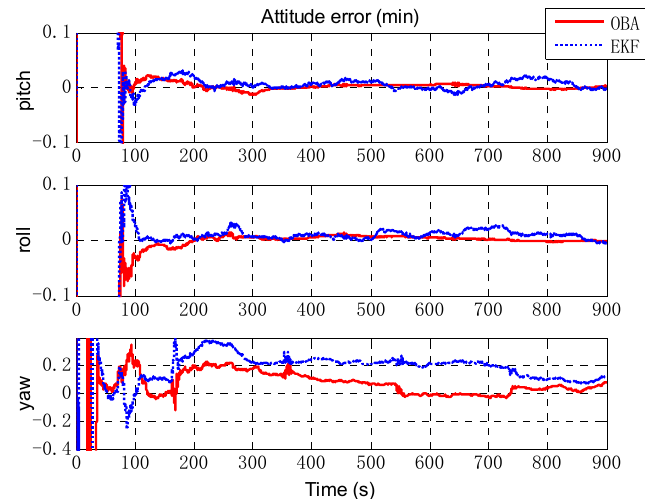
Figure 6. The estimation of attitude error. The red solid line denotes the estimation by OBA, and the blue dashed line denotes the estimation by EKF. The three figures are the attitude errors of pitch, roll and yaw respectively.